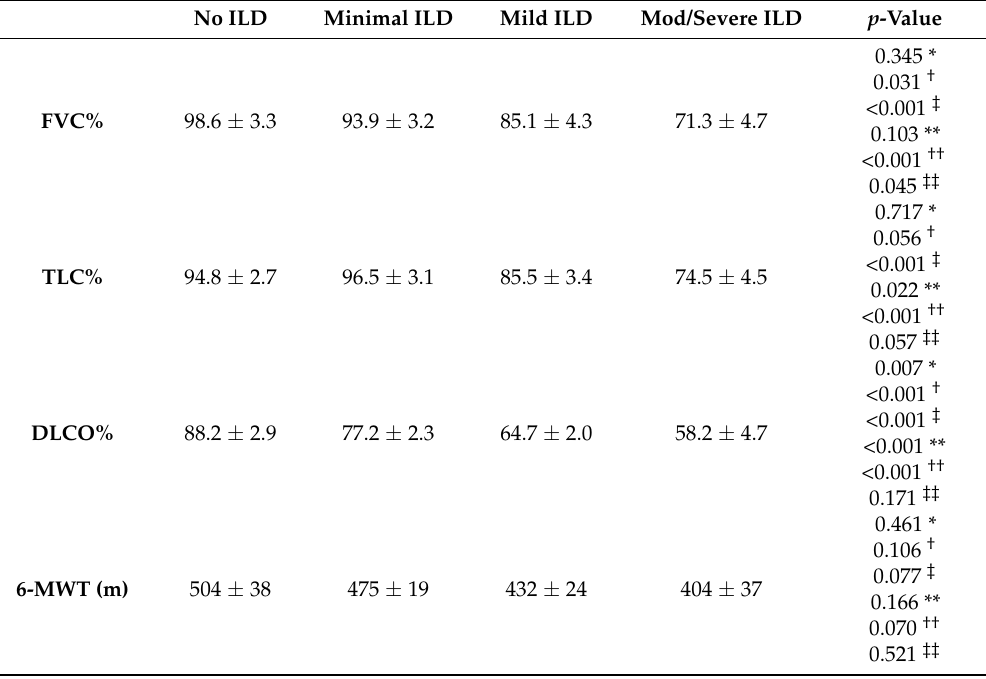
Table 2. Lung Function of Patients with Erdheim–Chester